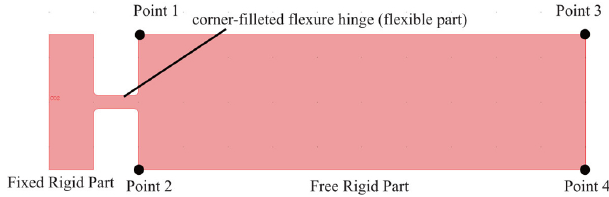
Figure 2. An analytical corner-filleted flexure hinge model.